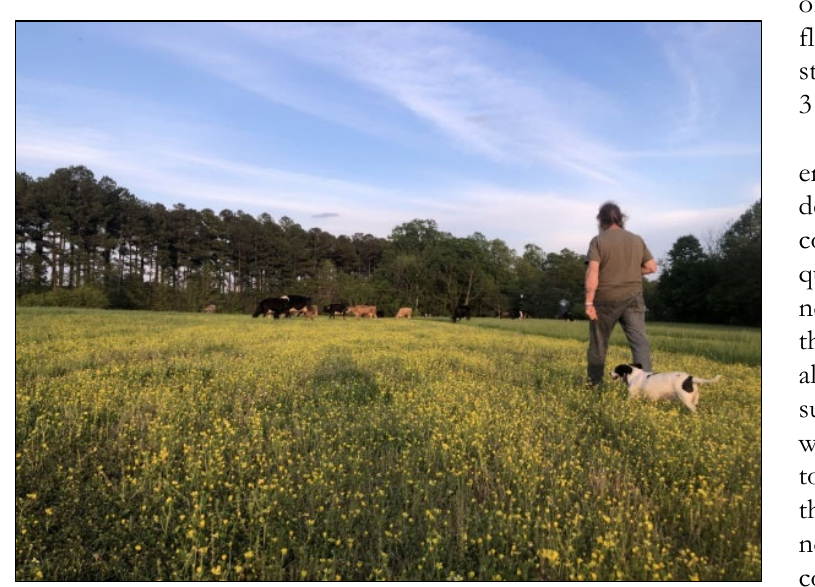
Figure 5. On Ran-Lew Dairy